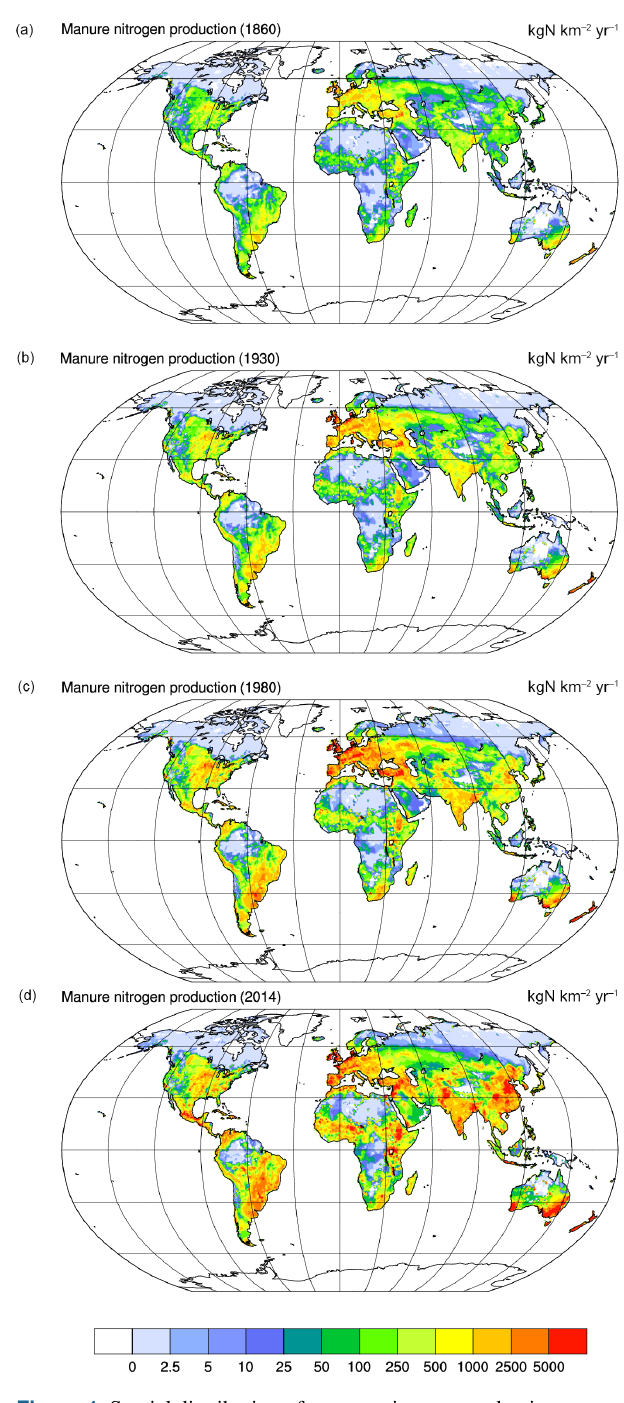
Figure 1. Spatial distribution of manure nitrogen production across the global land surface in the four years 1860, 1930, 1980, and 2014.